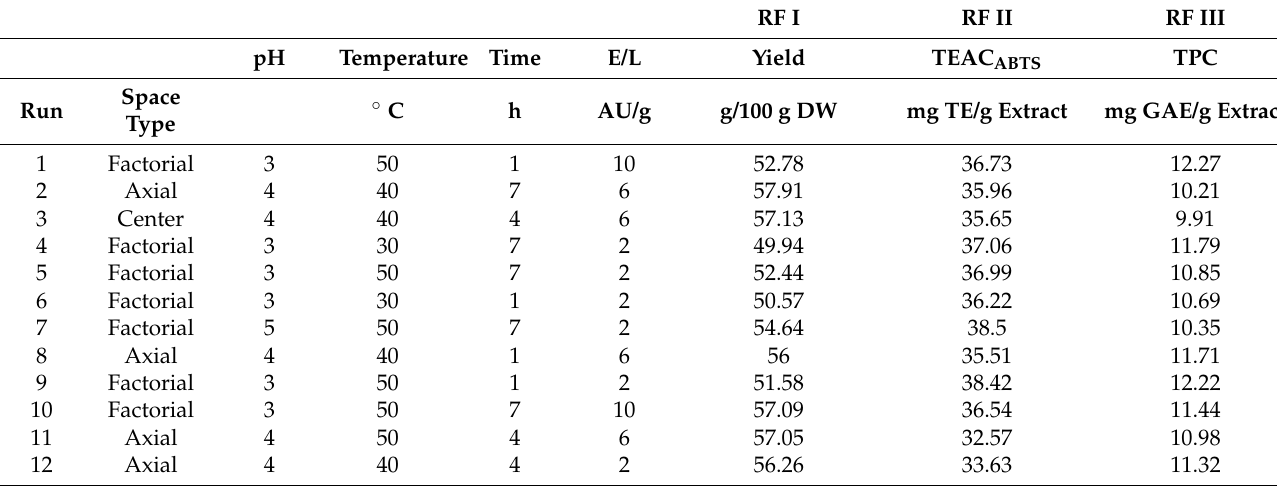
Table 1. Central composite design matrix for the enzyme-assisted extraction bilberry pomace and values of observed response factors RFI (Yield, g/100 g of residue after SFE-CO 2 ), RFII (TEAC ABTS , mg TE/g of extract), and RFIII (TPC, mg GAE/g of extract).